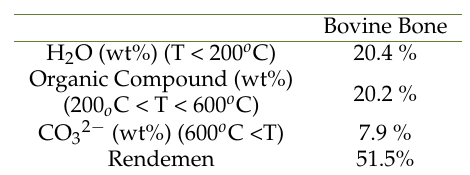
Table 1. The weight percentage of the cow bone sample is based on the graph in Fig.